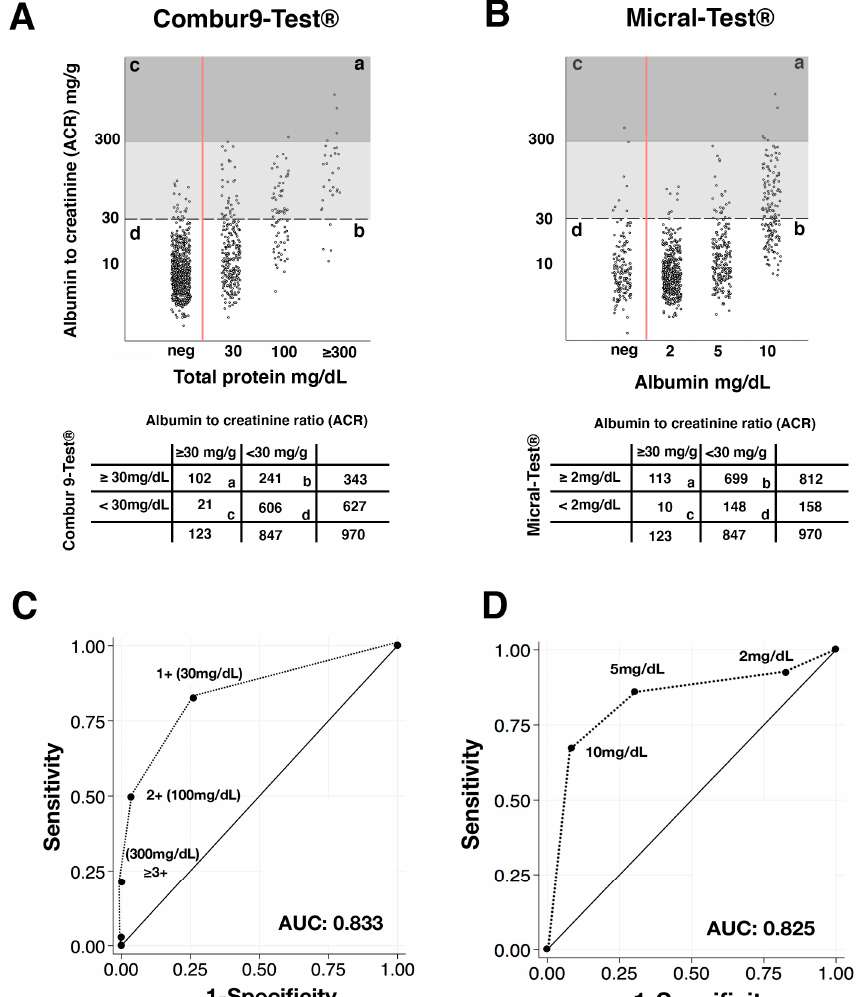
Figure 2. Correlation and agreement of the colorimetric indicator-dye-based urine Combur9-Test ® and the immunochromatographic albumin-specific urine Micral-Test ® with the albumin-to-creatinine ratio (ACR) reference test and distribution within KDIGO albuminuria classification. ( A , B ) with embedded tables: Correlation of Combur9-Test ® and Micral-Test ® with ACR: (a) dipstick positive and ACR ≥ 30 mg/g; (b) dipstick positive and ACR < 30 mg/g; (c) dipstick negative and ACR ≥ 30 mg/g; (d) dipstick negative and ACR < 30 mg/g. Dashed horizontal black line: albuminuria cut-off of ACR for positive testing at 30 mg/g; white area: albuminuria < 30 mg/g; light grey area: albuminuria 30–299 mg/g; dark grey area: albuminuria ≥ 300 mg/g; red line: dipstick negative versus positive; ( C , D ): Receiver operator curves (ROC) of index dipstick tests against ACR reference test with cut- off ≥ 30 mg/g for albuminuria. ( C ) Combur9-Test ® versus ACR reference test; ( D ) Micral-Test ® versus ACR reference test; AUC: area under the curve; black line: random classifier; dotted line: test